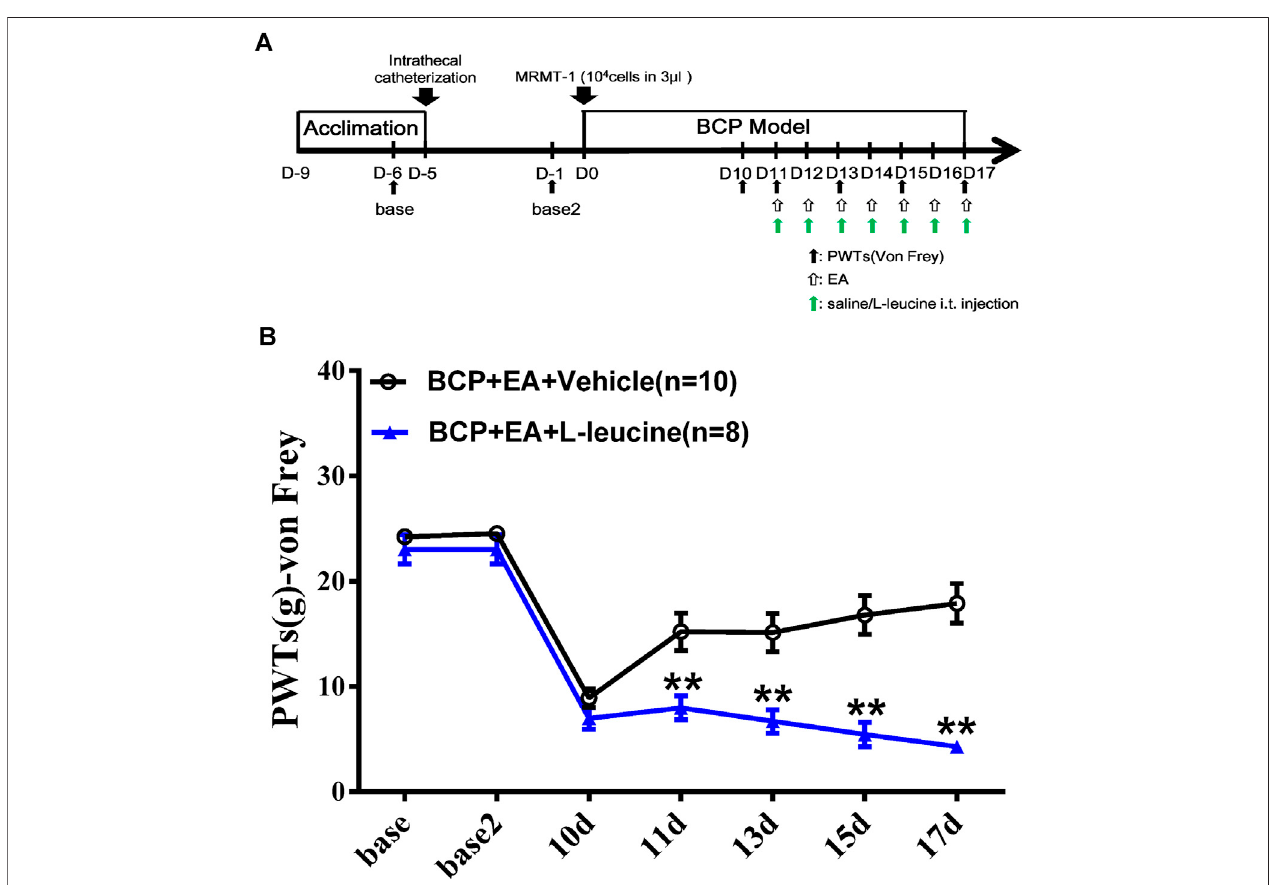
FIGURE 9 | Administration of mTOR agonist L-leucine impaired the analgesic effect of EA in BCP rats. (A) Animal experiment procedure for mTOR agonism in EA- treated BCP rats; (B) time-coursechange ofPWTs. Compared with the BCP + EA + vehicle group, the PWTs of the BCP +EA + L-leucine group dropped drastically on postoperative days 11, 13, 15, and 17. ** p < 0.01, compared with the BCP + EA + vehicle group.